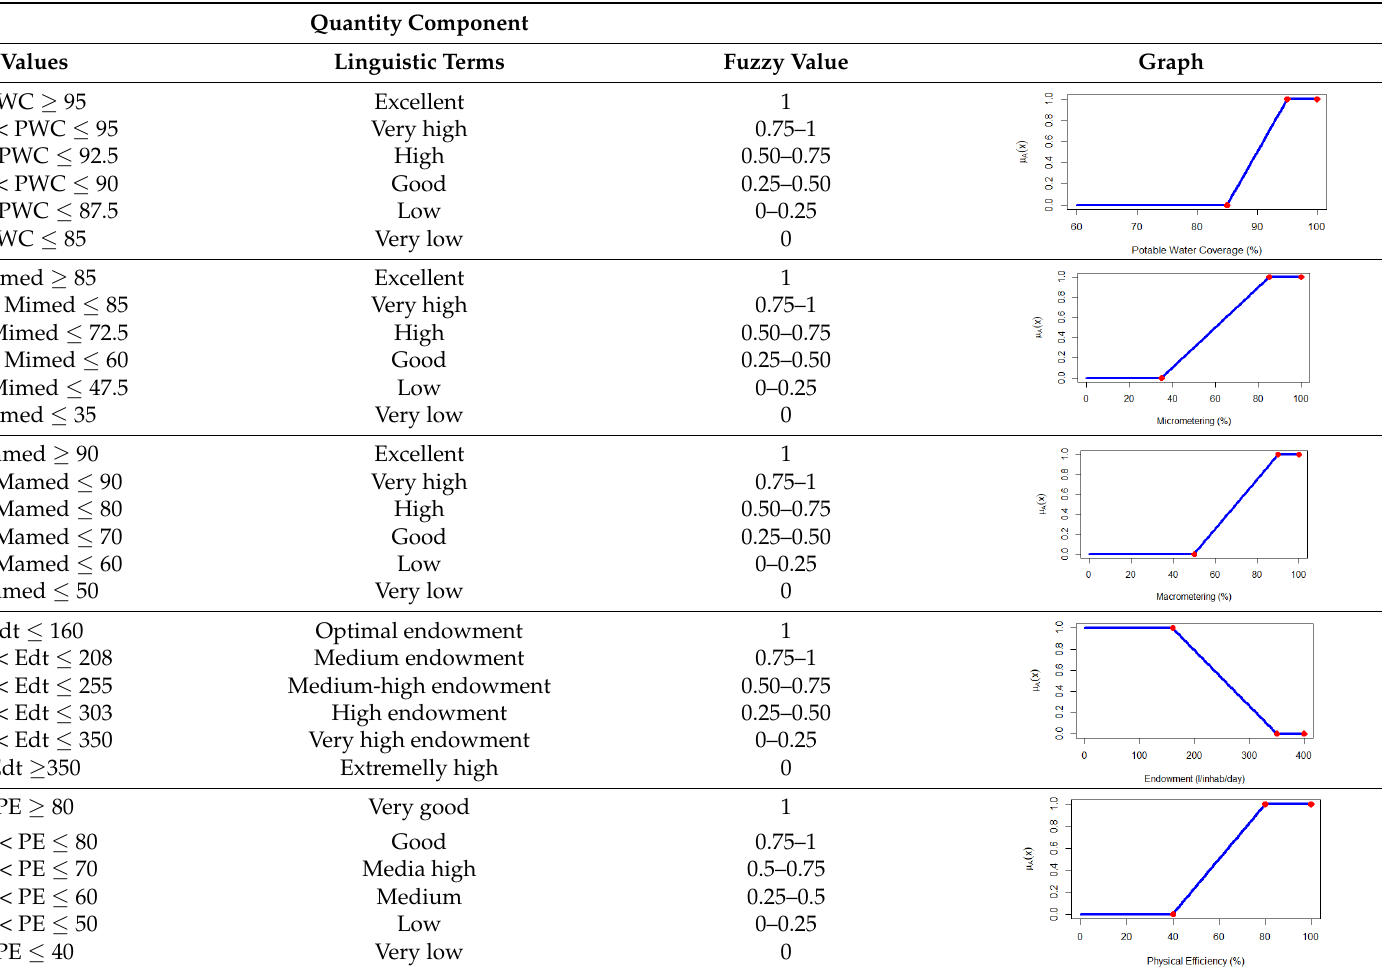
Table 2. Results of the FL method for each component with their respective indicators.